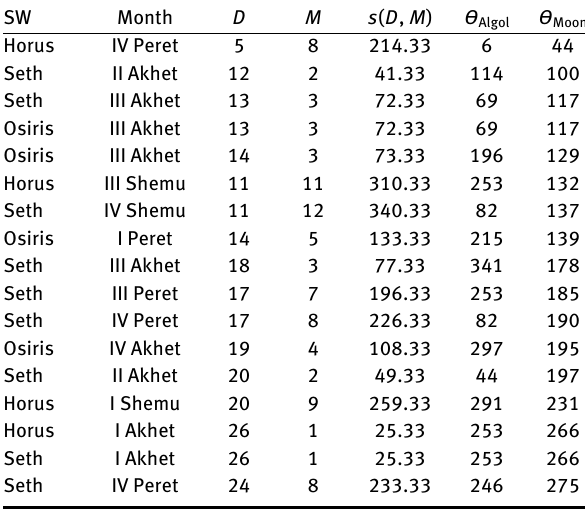
Table 4. “SSS” prognosis texts mentioning Horus, Seth or Osiris. Notations are as in Table